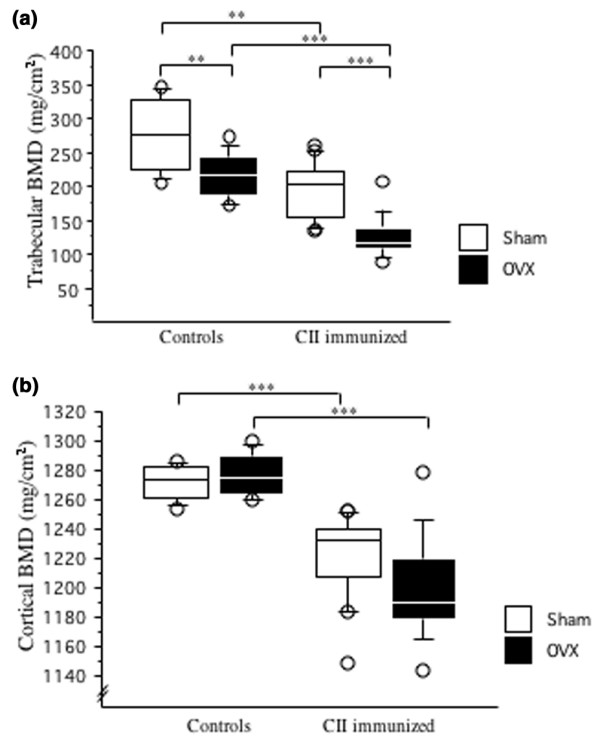
Ovariectomy decreased trabecular BMD whereas arthritis decreased both trabecular and cortical BMD. Peripheral quantitative computer tomography (pQCT) was performed to measure trabecular and cortical bone mineral density (BMD). (a) Trabecular bone mineral density (BMD) was determined with a metaphyseal scan at a point 3% of the length of the femur from the growth plate and the inner 45% of the area was defined as the trabecular bone compartment. (b) Cortical BMD of the femur was determined with a mid-diaphyseal scan. Results are shown as box plots (values are given as medians (horizontal lines), interquartile ranges (box) and ranges (whiskers); circles represent outliers). For controls, n = 10 for sham (open boxes) and ovariectomy (filled boxes); for immunized mice, n = 18 for sham and n = 14 for ovariectomy. **P < 0.01; ***P < 0.001. CII, type II collagen.